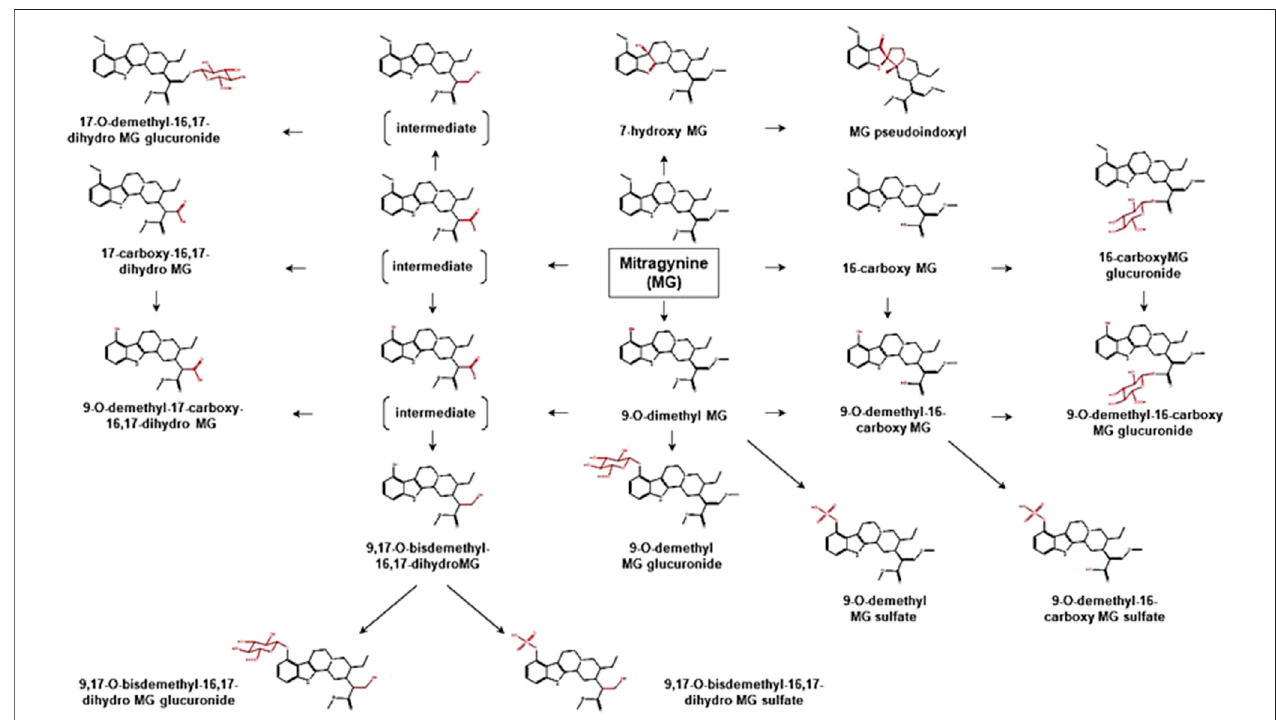
FIGURE 2 | Proposed metabolic pathways of MG based on data obtained in rodents and humans. Structures highlighted in red denote structural transformation from parent molecule MG. Figure was modi fi ed from Philipp et al. (2009) and Kamble et al. (2020).